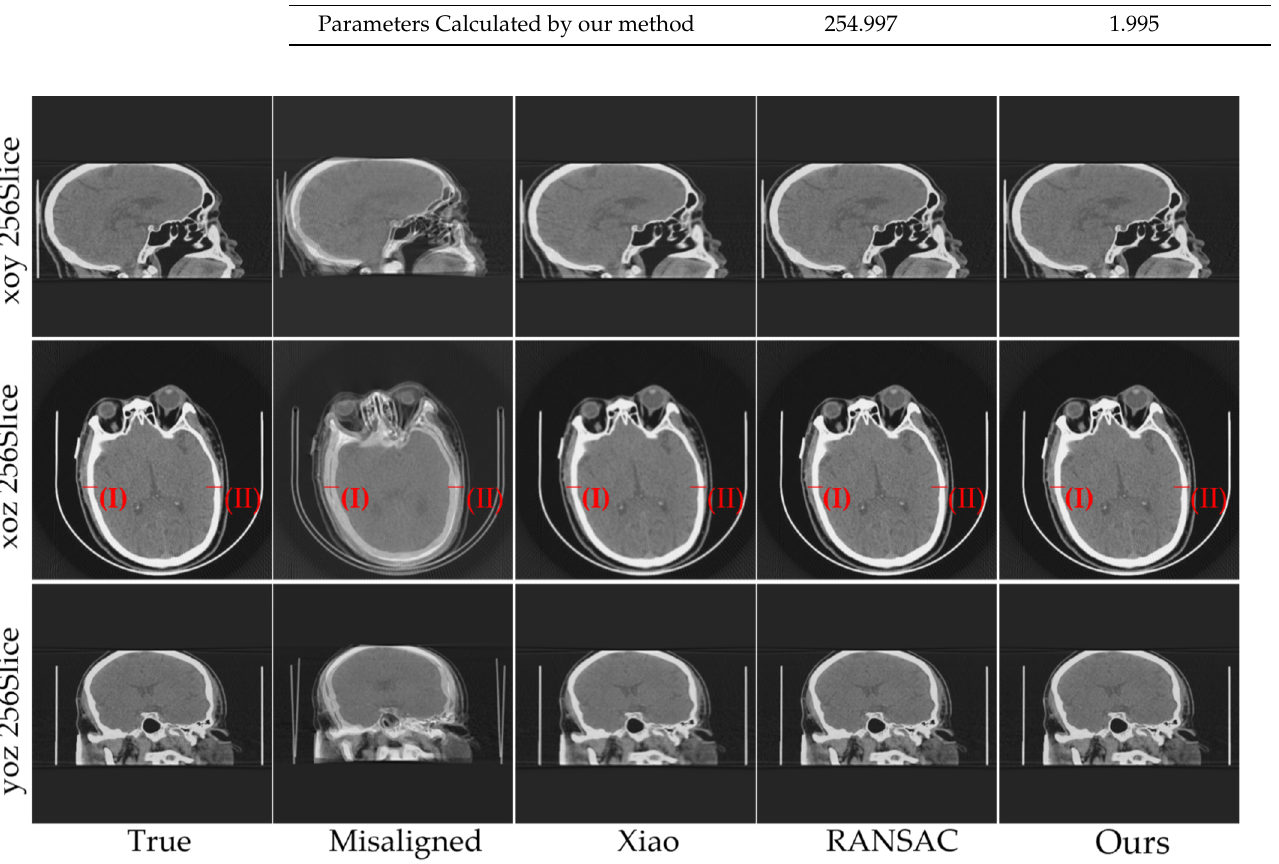
Figure 4. The Head data reconstruction results with different geometric parameters.